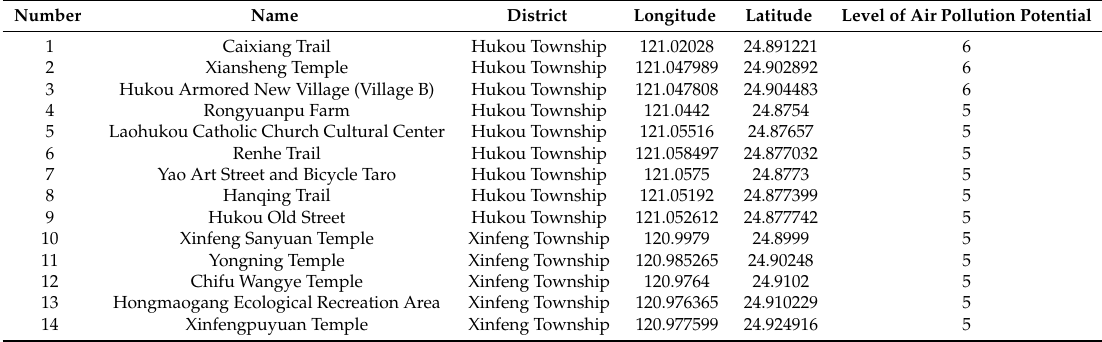
Table 4. Highest air pollution potentials of tourist attractions—levels 5 and 6—in Hsinchu County.